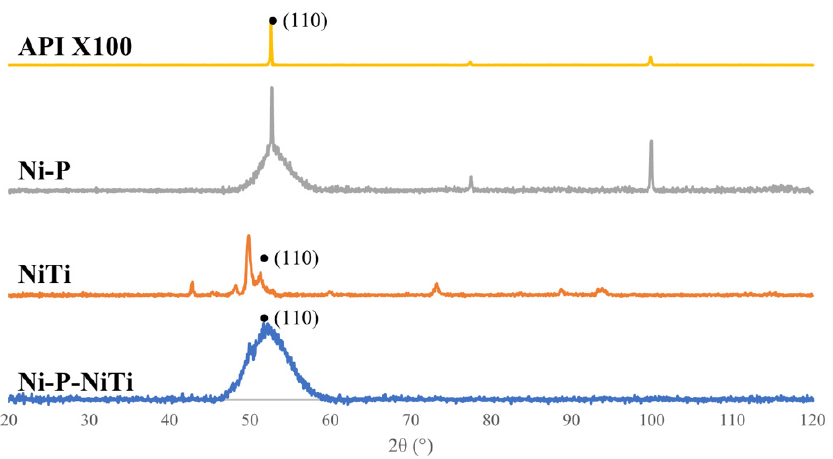
Figure 1. Micro-Indentation Load-Depth Curve Examples.